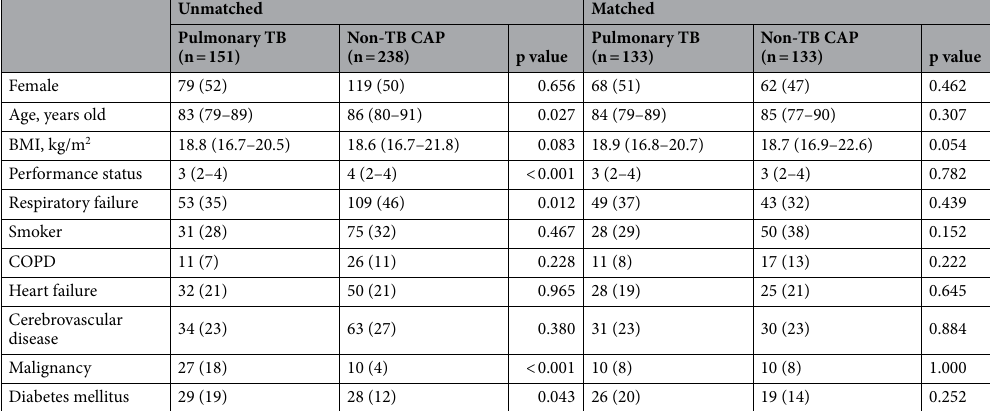
Table 1. Clinical characteristics of elderly patients with pulmonary tuberculosis and those with non- tuberculosis community-acquired pneumonia (CAP). Data are presented as number (%) or median (interquartile range). BMI body mass index, CAP community-acquired pneumonia, COPD chronic obstructive pulmonary disease, TB